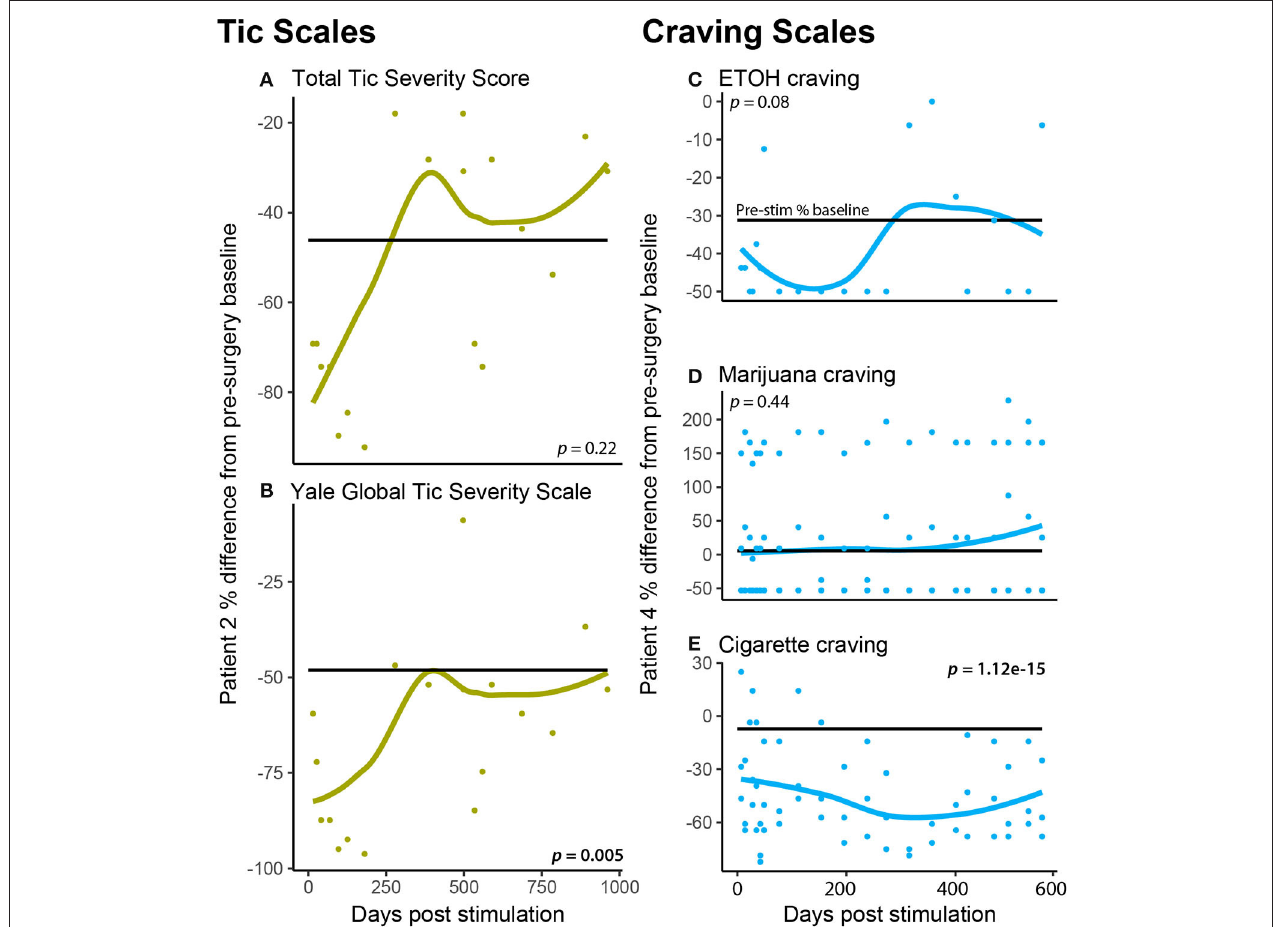
FIGURE 3 | Patient specific comorbidities. (A,B) A patient (P2) had a comorbid autism-spectrum disorder, tic disorder, which was measured at each DBS programming session using the (A) Total Tic Severity Score and the (B) Yale Global Tic Severity Scale (C–E) . A patient (P4) had comorbid substance use (nicotine use disorder, daily cannabis use, and at-risk alcohol use), which was measured at each DBS programming session using craving scales for ETOH (C) , marijuana (D) , and cigarettes (E)